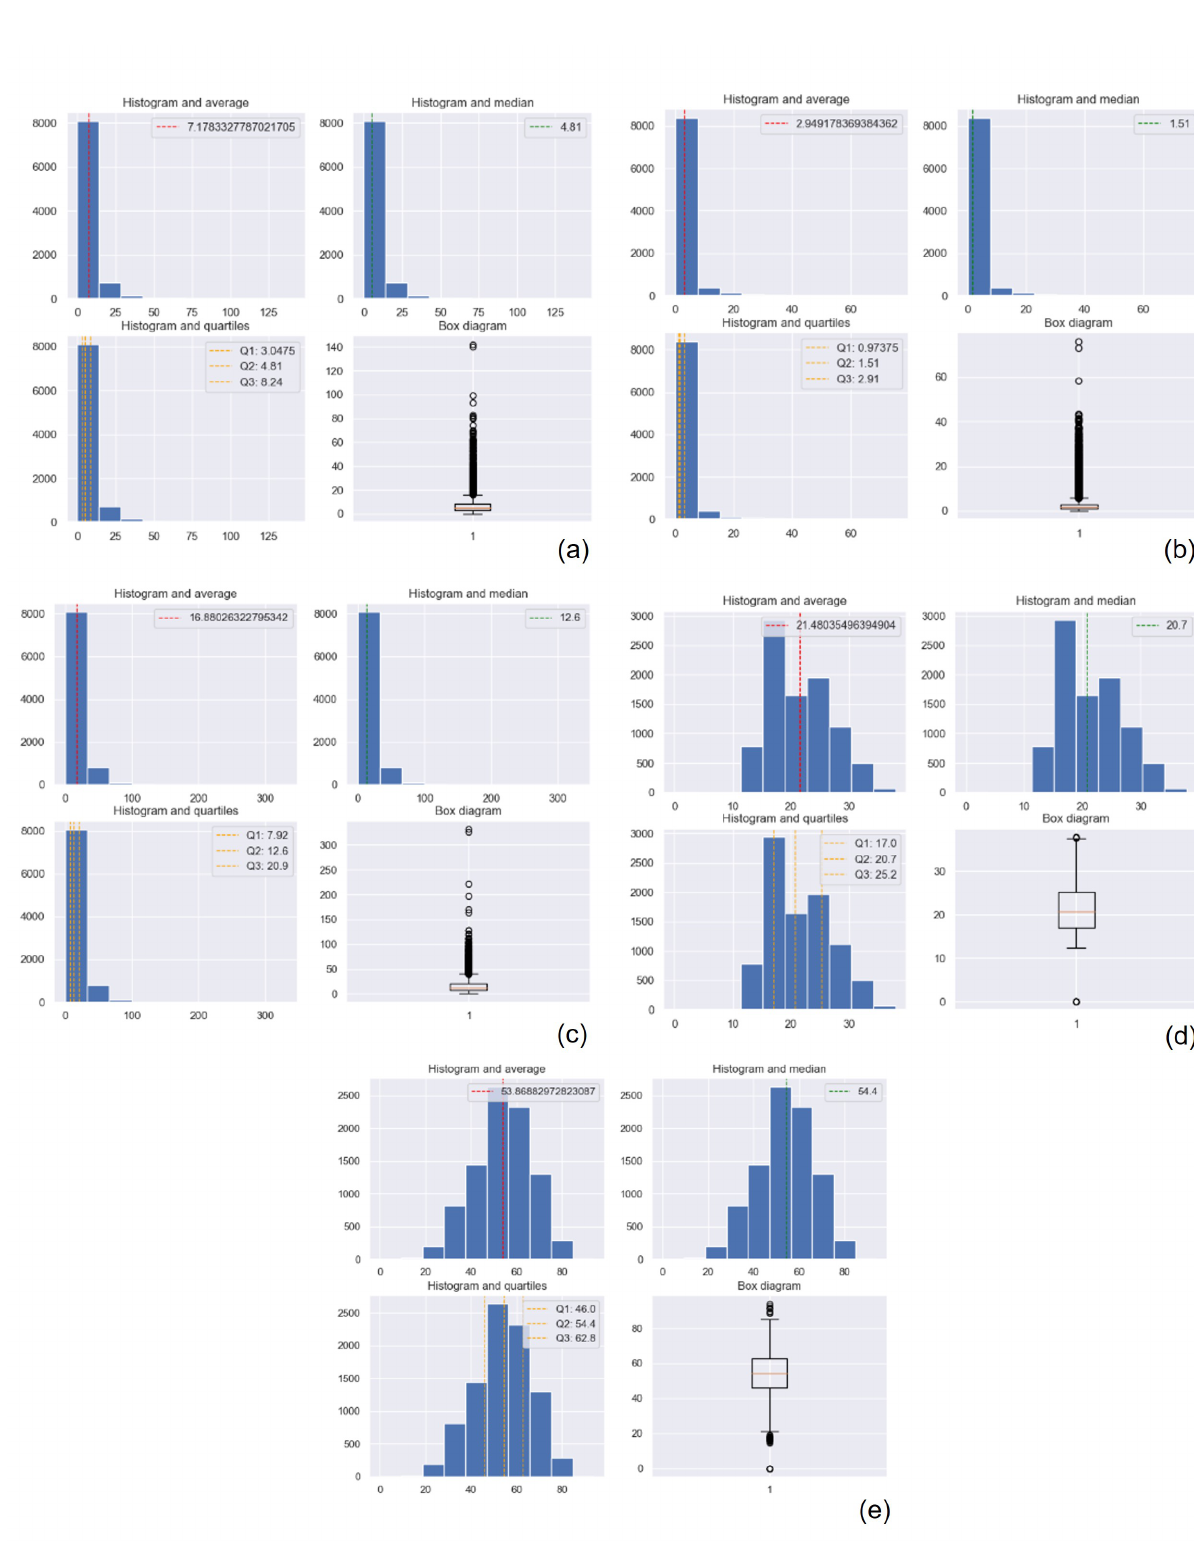
Figure A3. Statistics for ( a ) PM 2.5 ( b ) PM 1 ( c ) PM 10 ( d ) Temperature and ( e ) Humidity for particulate matter measuring device #